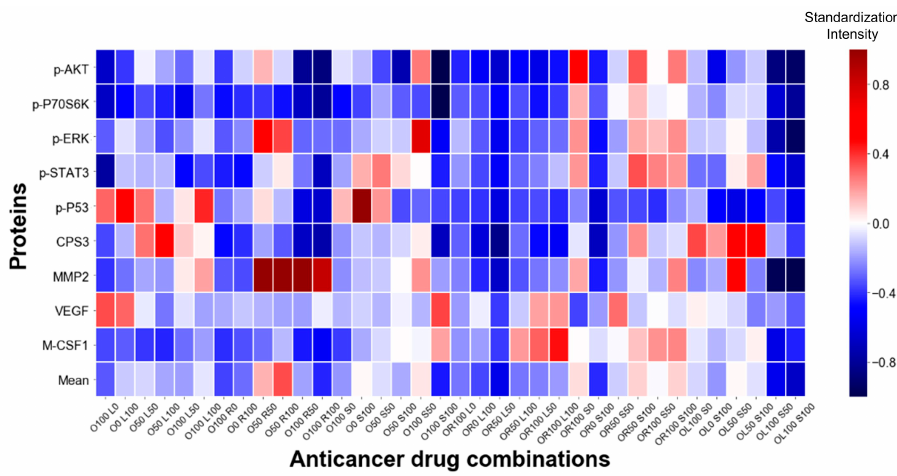
Figure 3. Heat map showing average protein concentration. The average protein concentration after anti-cancer drug treatment, for each drug, is illustrated using a heat map. O, Oximertinib; L, LY294002; R, Ruxolitinib; S,